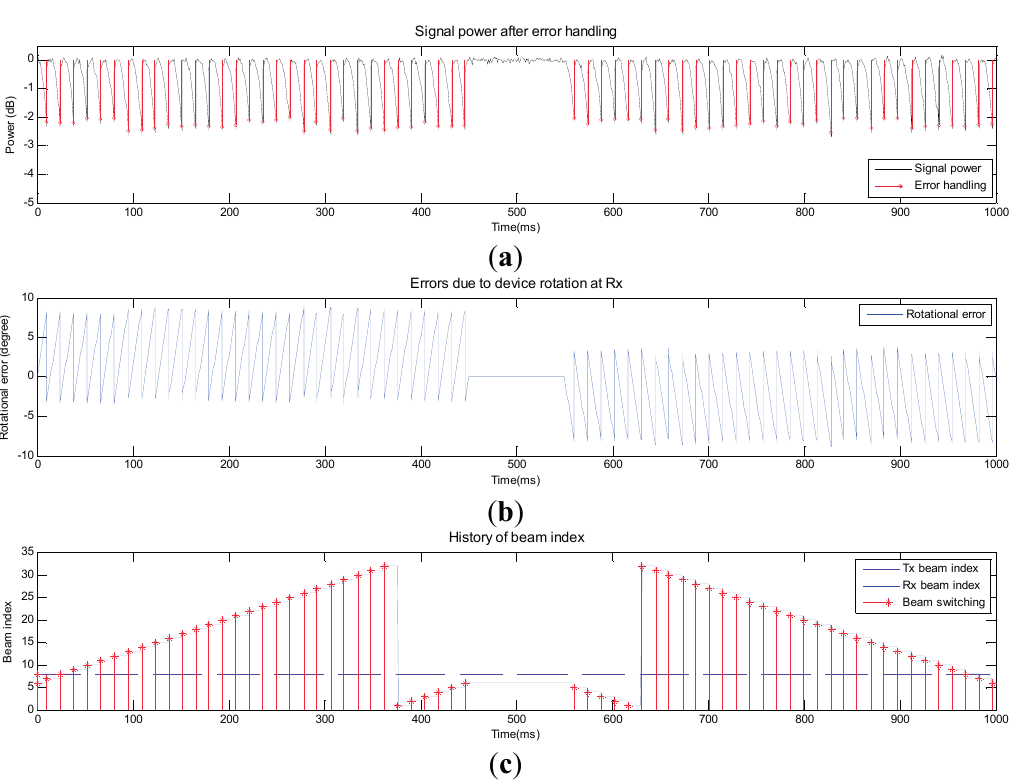
Figure 6. Performance of the proposed beam-tracking technique in Scenario